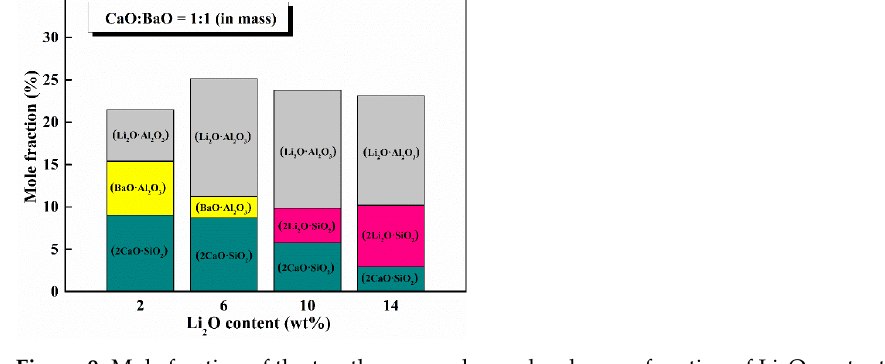
Figure 9. Mole fraction of the top three complex molecules as a function of Li 2 O content.